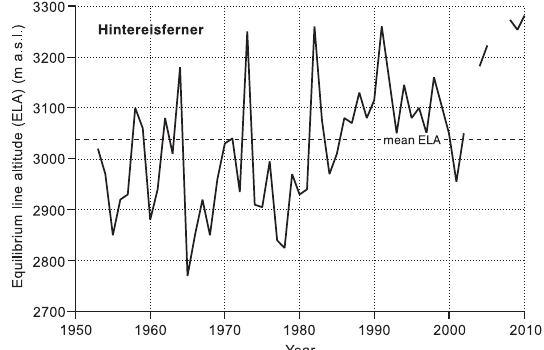
Table 1. Summary of glacier altitudes for Hintereisferner, Austrian Alps, based on area–altitude data for the year